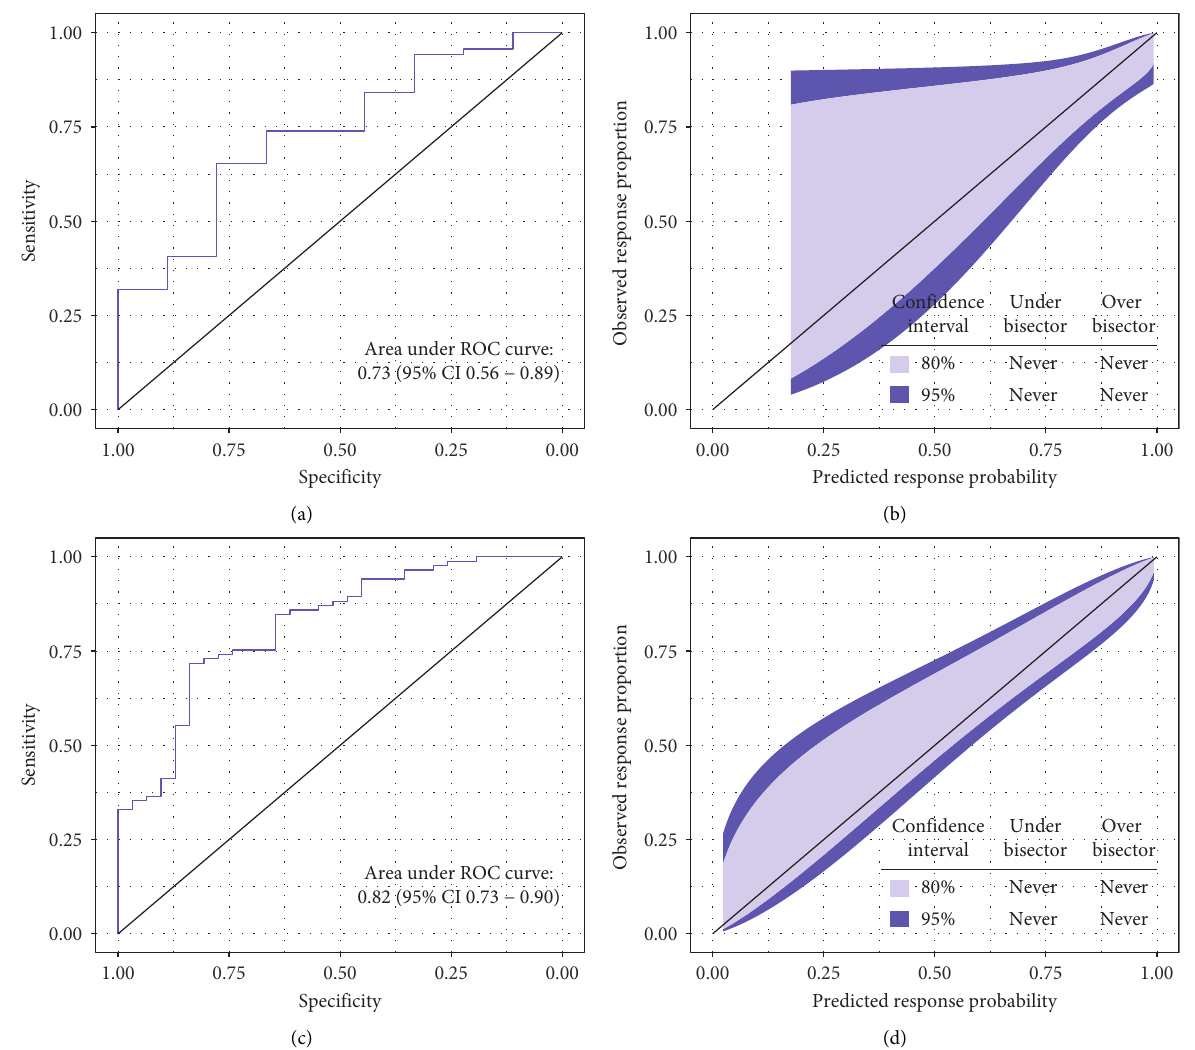
Figure 4: Predictive performance of the URS in patients with normal and increased baseline AT values. (a) Good discrimination ability in patients with normal baseline AT values. (b) Calibration belt in patients with normal baseline AT values characterized by wide confidence intervals in the lower predicted probabilities range. (c) Good discrimination ability in patients with increased baseline AT values. (d) Calibration belt demonstrating good calibration in patients with increased baseline AT